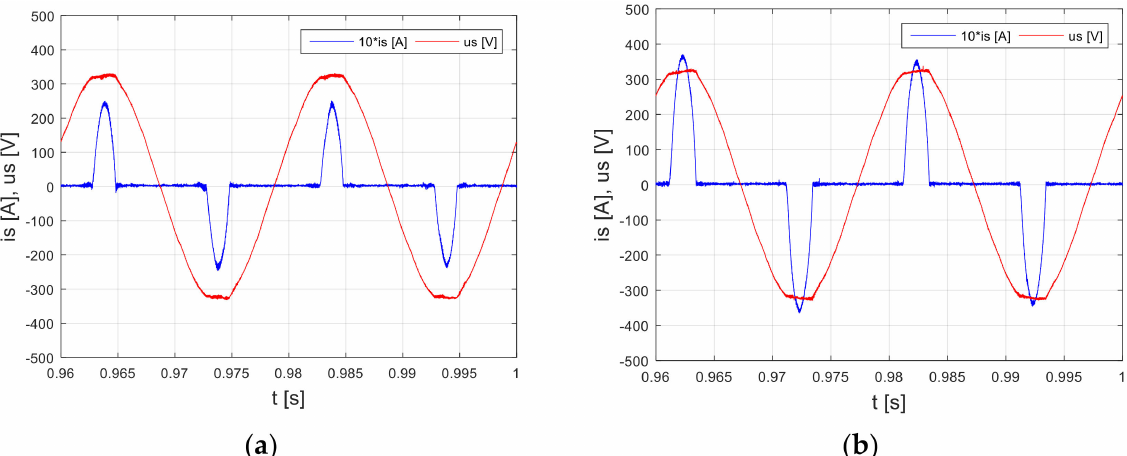
Figure 10. Waveforms of the converter input current (is) and voltage (us) at the 60 bar pressure for the speed of: ( a ) 1000 rpm; ( b ) 1500 rpm.